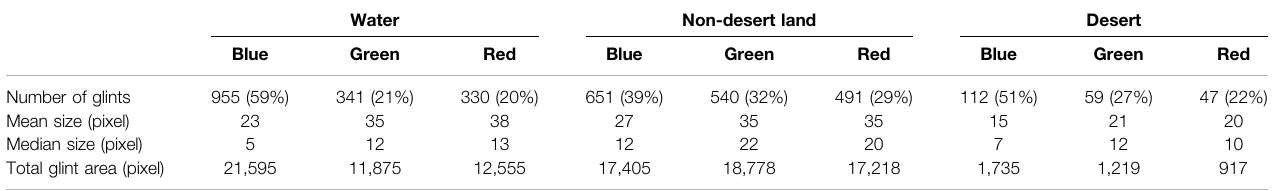
TABLE 1 | Number and size of glints detected by the EPIC glint product. The numbers in parentheses indicate, what the fraction of all glints detected over a certain surface type are detected at each color. Water Non-desert